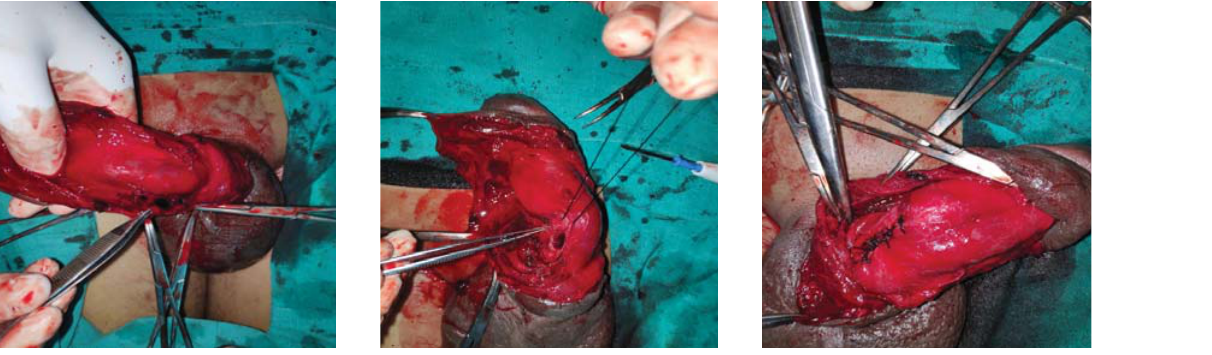
Figure 2. Degloving of the shaft of injured penis